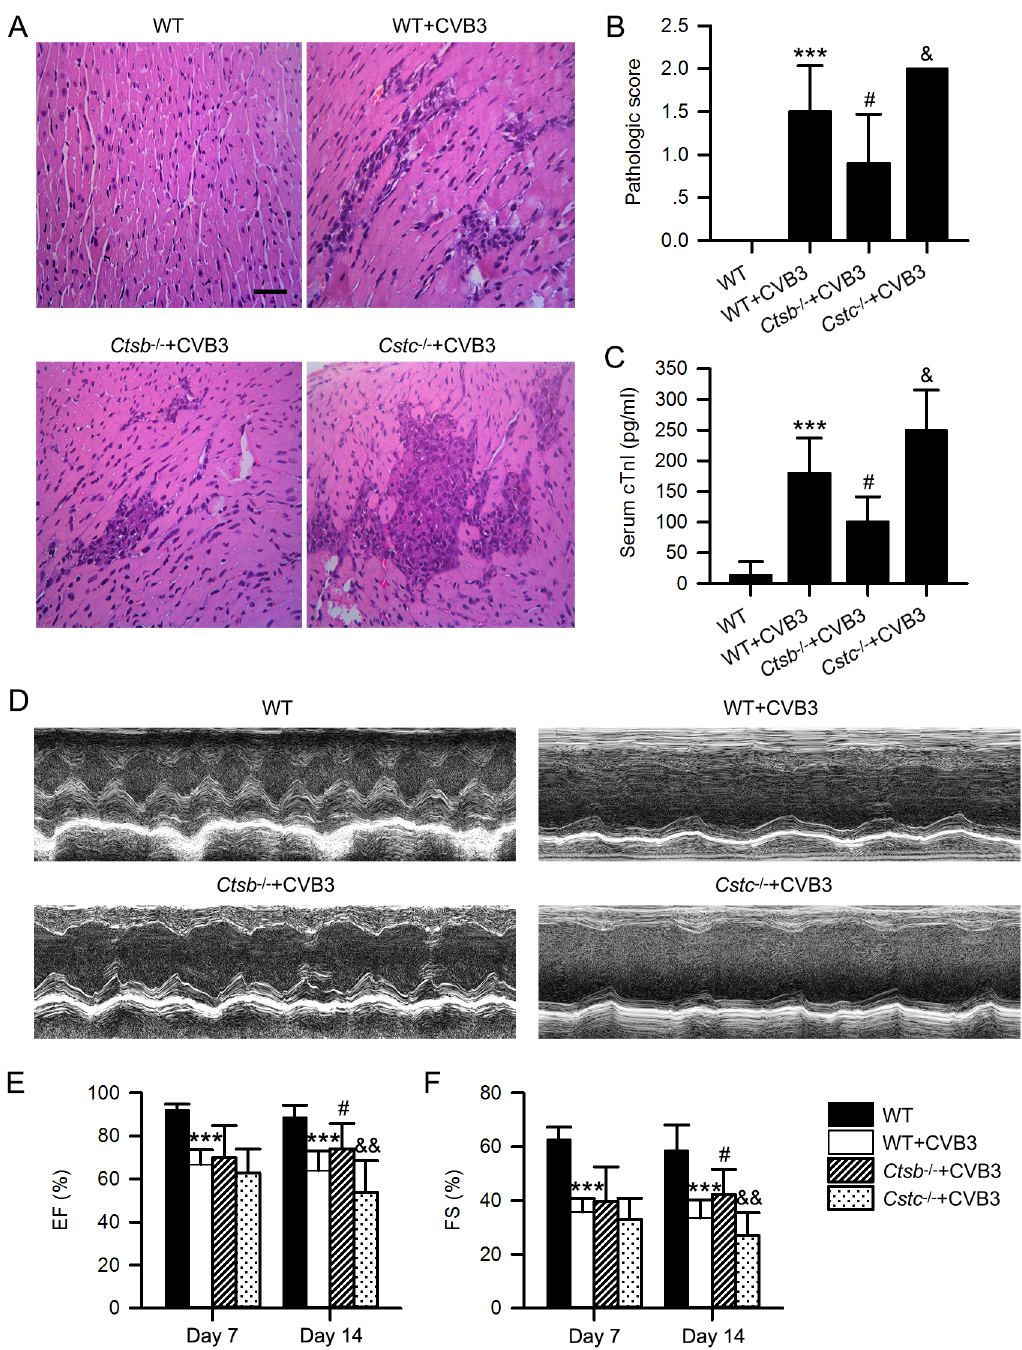
Fig 4. CatB deficiency alleviated while cystatin C deficiency aggravated the severity of CVB3-induced VMC. (A, B) Representative HE staining in hearts from mice of indicated intervention. Scale bar: 50μm. The HE staining showed the infiltration of inflammatory cells and pathologic score was significantly decreased in Ctsb -/- +CVB3 group while increased in Cstc -/- +CVB3 group on day 7 pi, compared with WT+CVB3 group. (C) The serum cTnI level was significantly lower in Ctsb -/- +CVB3 group and higher in Cstc -/- +CVB3 group than the WT+CVB3 group on day 7 pi. (D-F) The echocardiographic data showed that cardiac dysfunction caused by CVB3 infection was significantly alleviated in Ctsb -/- +CVB3 group, though there was no statistical difference between the Cstc -/- +CVB3 group and the WT+CVB3 group. (WT group: n = 10; WT+CVB3 group: n = 14; Ctsb -/- +CVB3 group: n = 12; Cstc -/- +CVB3 group: n = 11; (cid:3)(cid:3)(cid:3) P < 0.001 vs . WT group; #P < 0.05 vs . WT+CVB3 group; &P < 0.05 vs . Ctsb -/- +CVB3 group; &&P < 0.01 vs . Ctsb -/- +CVB3 group).